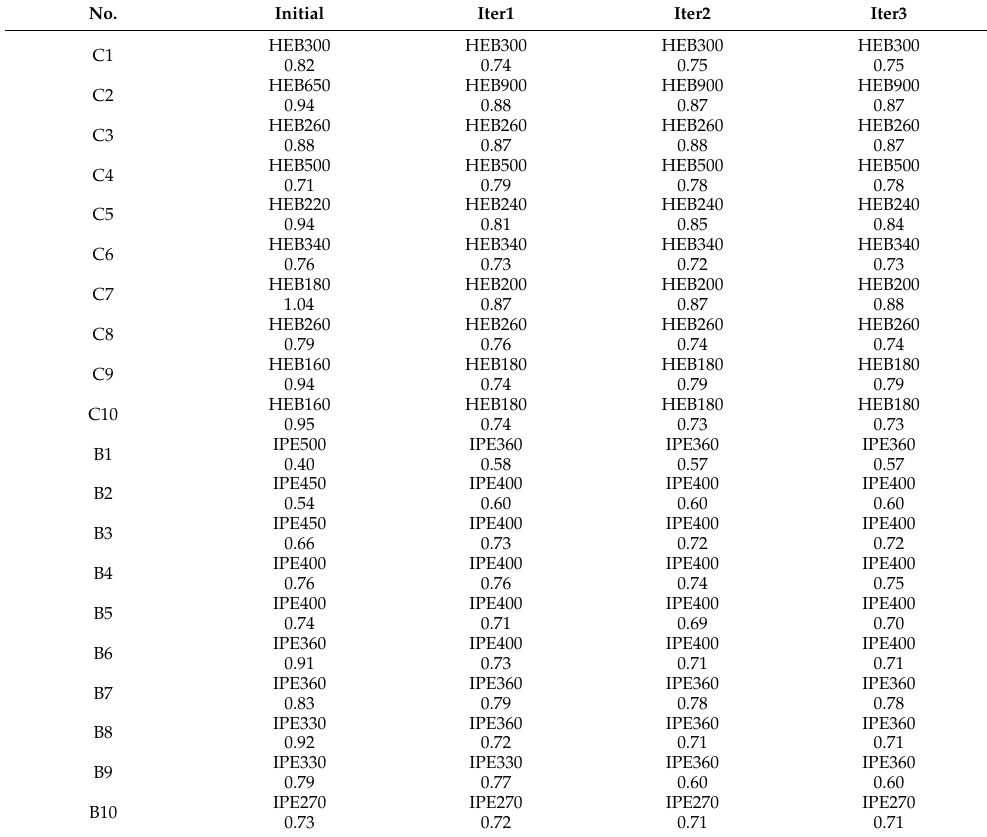
Table A3. Members and their most unfavorable ratio of demand to capacity in each iteration.